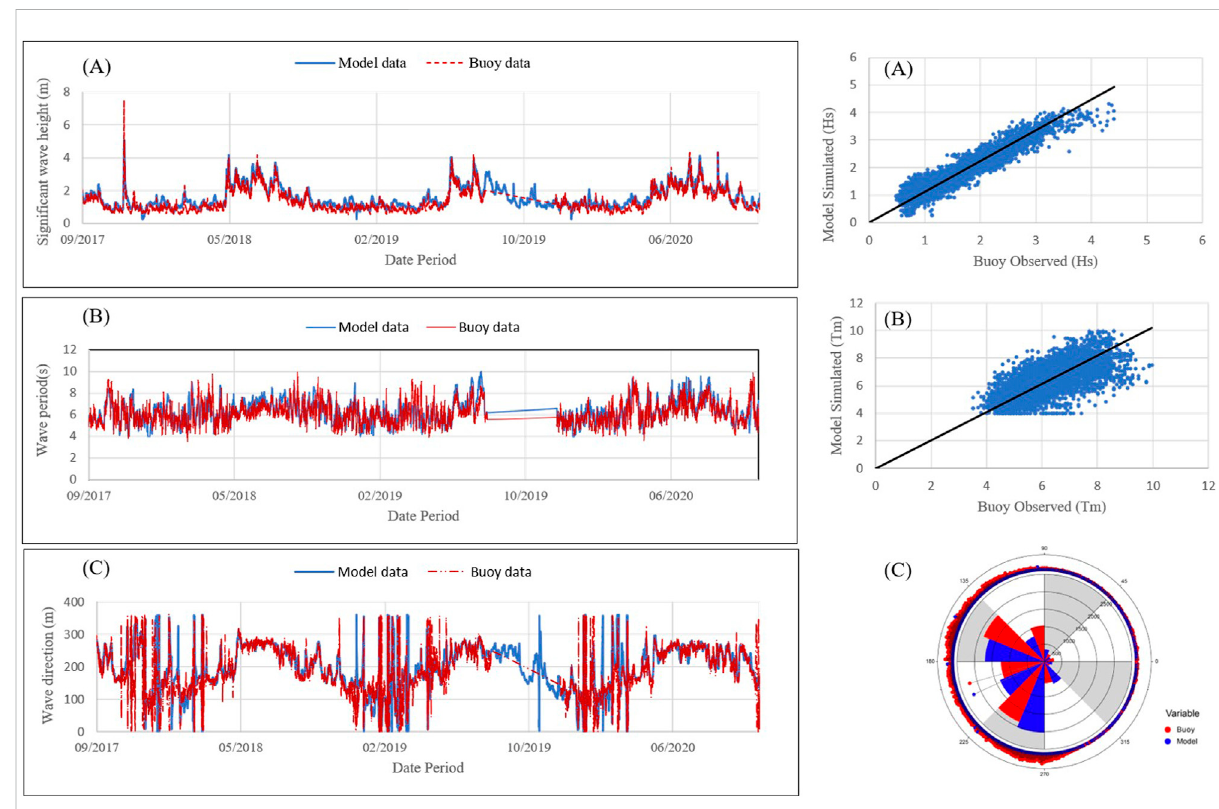
FIGURE 5 (left panel) Comparison of signi fi cant wave height between the modelled data and measured data at AD09 (A) Signi fi cant wave height (B) Mean wave period (C) Mean Wave direction; (right panel) Correlation between model simulated data and observed Buoy AD09 data (A) Signi fi cant wave height (B) Mean Wave period (C) Mean Wave direction.